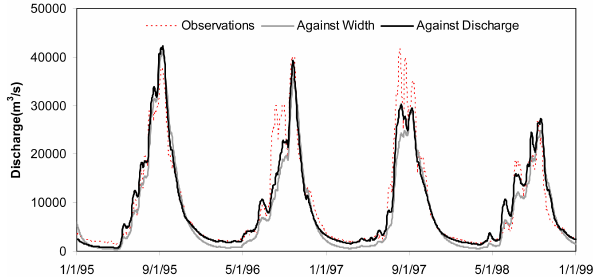
Fig. 8. Discharge time series at Pakse from observations, mean sim- ulation of behavioural parameter sets by calibration against satel- lite observations of river width, and best simulation by calibration against observed discharge data.